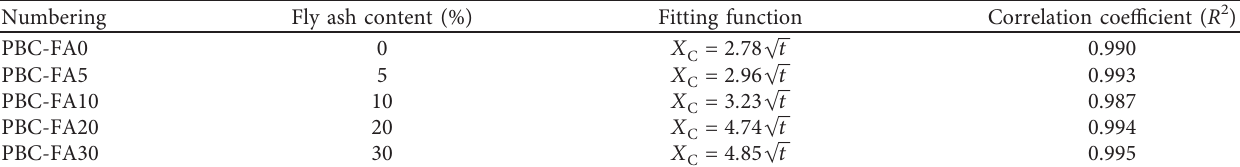
Table 4: Fitting function of carbonation depth and carbonation time of hybrid fiber concrete.